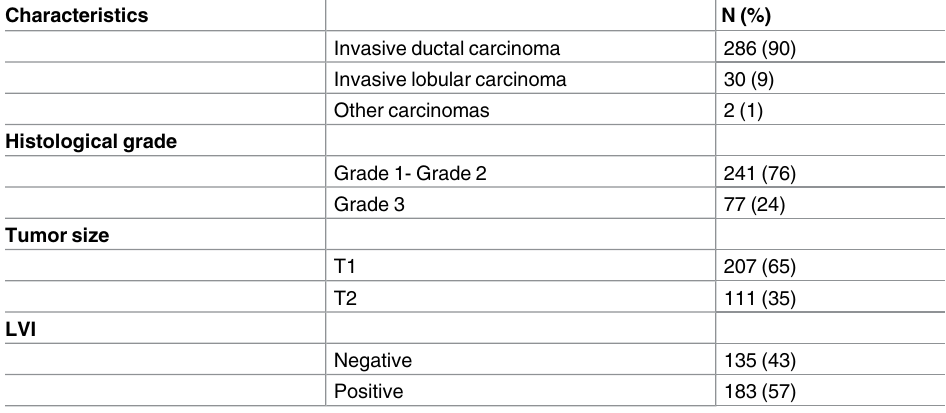
Table 1. Clinico-pathological characteristics of the patients (N =